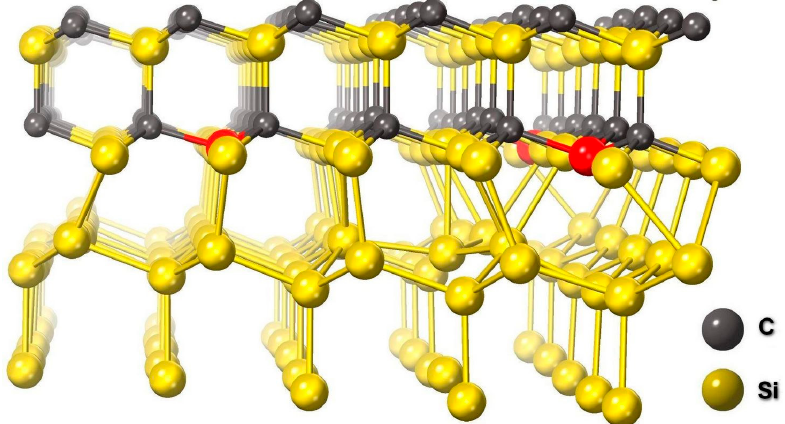
Figure 6. Atomic configuration corresponding to the optimal dislocation-free 3C-SiC(111)/Si(111) interface, calculated by the methods of quantum chemistry in the framework of DFT. The symmetry of the system corresponds to P3m1. The red color highlights those Si atoms at the SiC boundary that do not form bonds with the Si atoms of the substrate since they are too far from those.